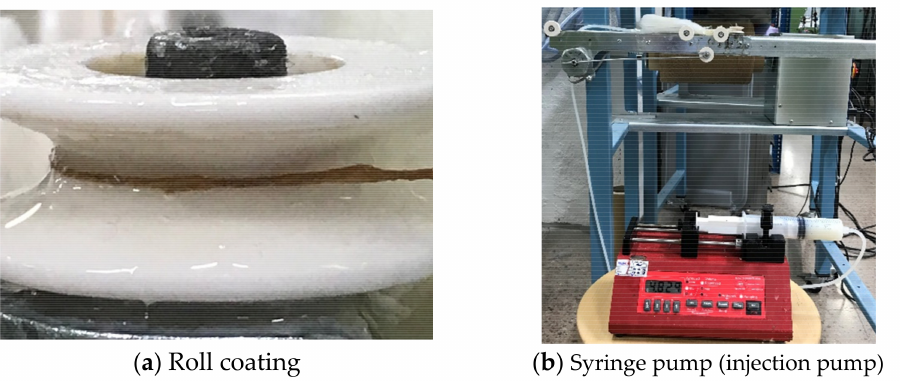
Figure 2. Finishing material application on yarn was made using ( a ) Roll coating where finishing material was applied to the yarn during movement; ( b ) Syringe pump used for injection of the finishing material at the targeted rate.